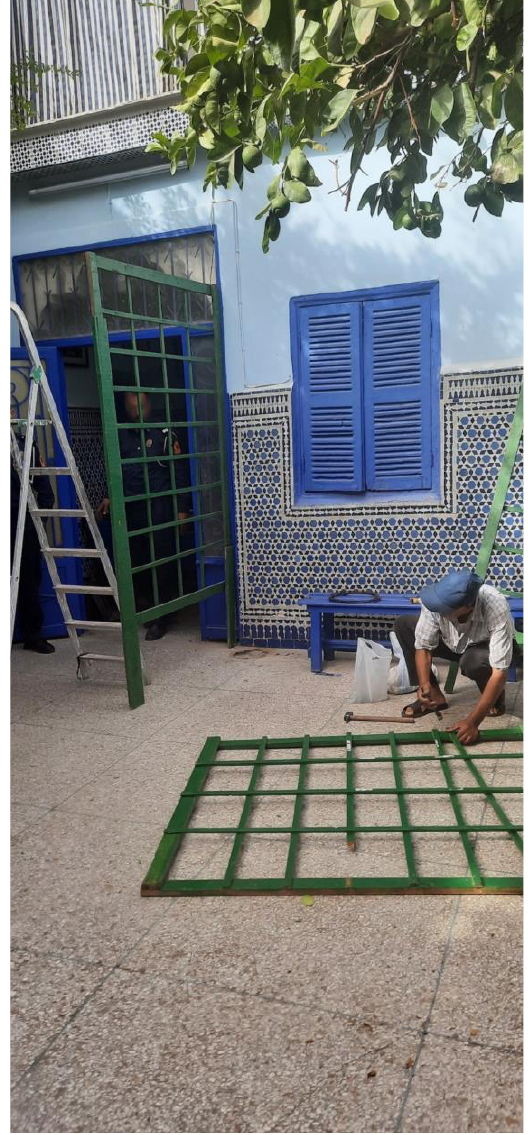
Figure 1. A Muslim building a Sukkha.